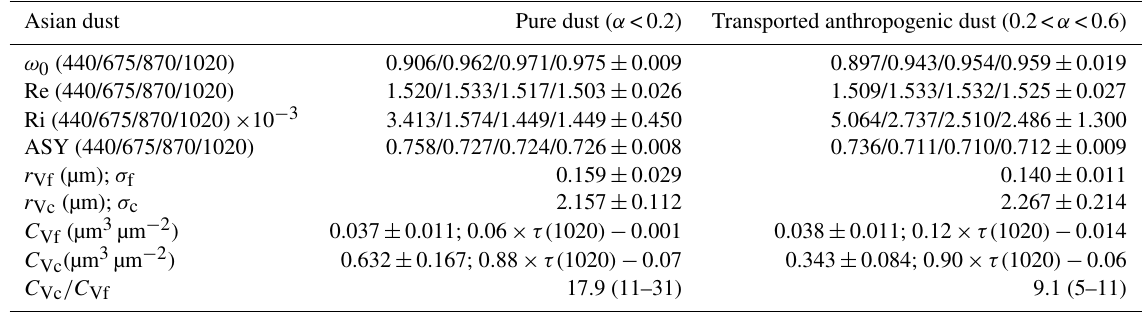
Figure 5. Overall average of aerosol volume size distributions in the entire atmospheric column for (a) Pure Dust ( α <0.2) and (b) Transported Anthropogenic Dust (0.2< α <0.6) at 13 selected AERONET sites. Corresponding aerosol optical depth at 440nm (AOD 440 ) and effective radius of coarse mode ( r coarse ) in µm are also shown. Note that the “–” in panel (b) represents missing data for AOD 440 and r coarse at the Dunhuang and Minqin sites. Table 2. Spectral optical properties of Pure Dust ( α <0.2) and Transported Anthropogenic Dust (0.2< α <0.6) averaged for 13 sites over East and Central Asian areas. Asian dust Pure dust ( α